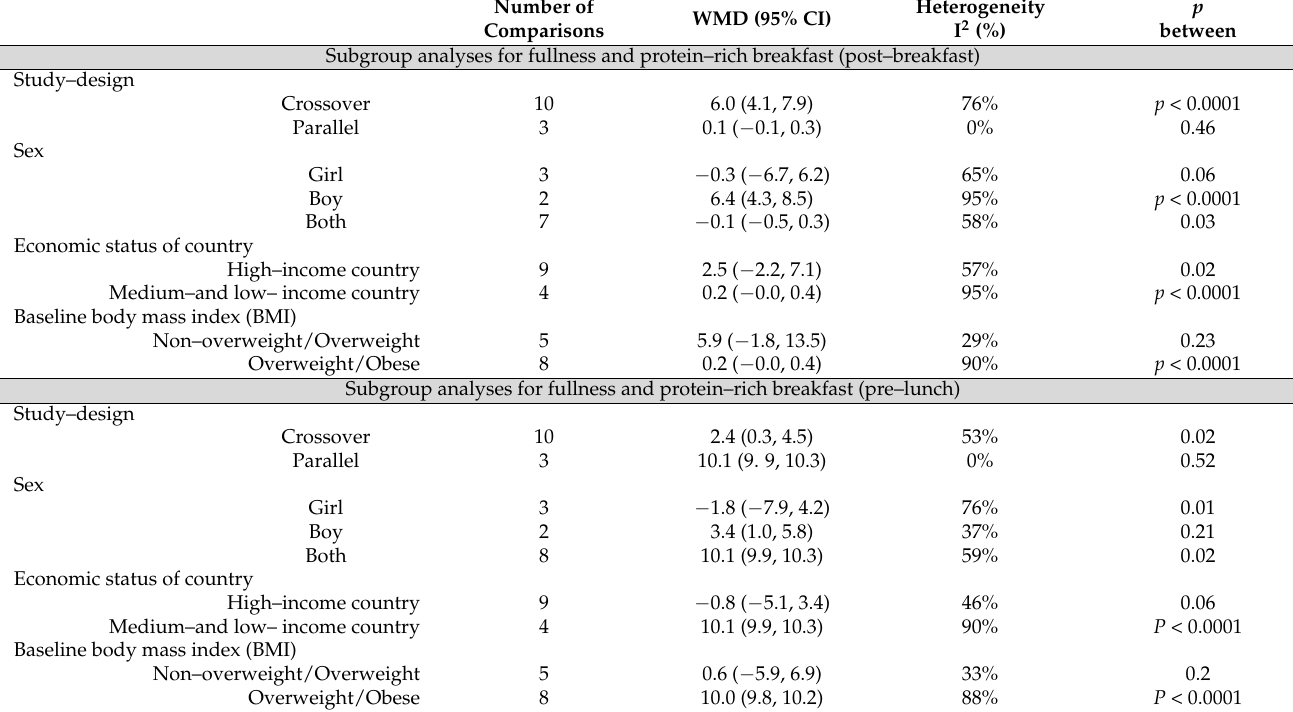
Figure 5. Random–effects meta–analysis of relationships between protein–rich breakfast and fullness (mm). Data for Baum 2015a are based on non–overweight participants, whereas data for Baum 2015b are based on overweight participants. Bellissimo 2020a [20], Bellissimo 2020b [20], and Bellissimo 2020c [20] are based on different subsets of subjects who identified as different dose protein breakfast consumers. Data for Douglas 2019a [21] are based on different subsets of subjects who habitually skipped breakfast, whereas data for Douglas 2019b [21] are based on different subsets of subjects who habitually consumed breakfast. Kral2016a (Oatmeal vs. Scrambled eggs) [15], Kral2016b (Cereal vs. Scrambled eggs) [15], Mehrabani 2015a (LFM vs. W) [23], and Mehrabani 2015b (LFM vs. AJ) [23] are based on different subsets of subjects who identified as different control groups, respectively. Other studies were defined as Leidy 2010 [16], Liu2015 [14], Wang2014 [17], and Wang 2015 [24], respectively. Table 6. Results of subgroup–analysis for fullness (mm) and protein–rich